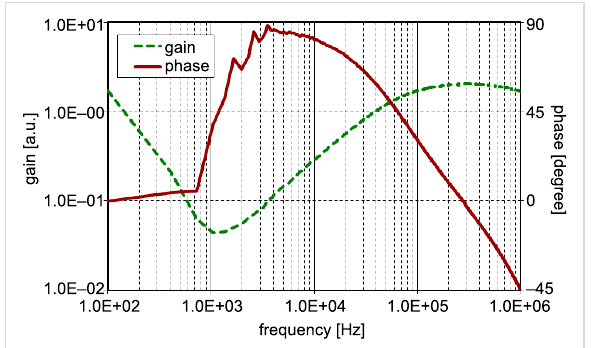
Figure 2: Transfer function of the differentiator in the Q-control circuit with a cutoff frequency of about 80 kHz. The solid and broken lines indicate phase and gain, respectively.